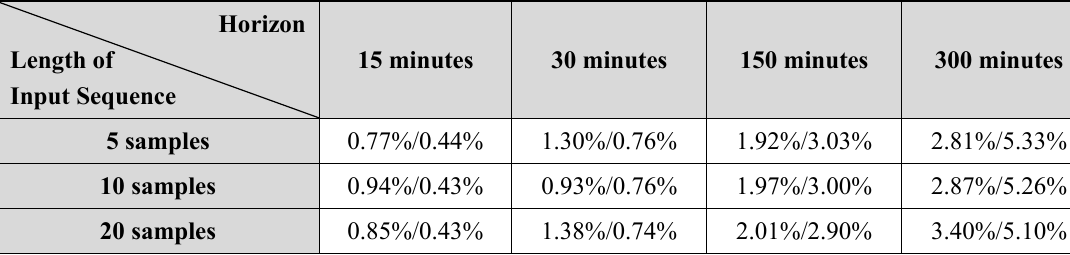
Table 3. Data prediction results (% error ANN/% error interpolation) for temperature in Sensor 1, using temperature in Sensor 1 as an